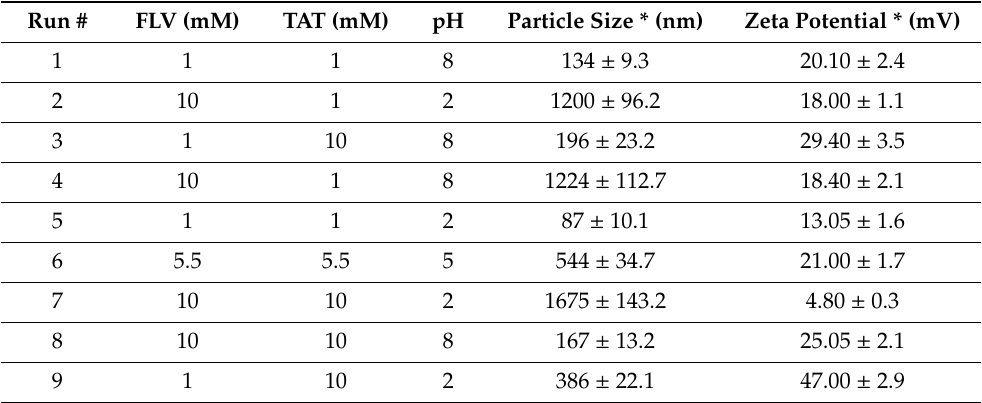
Table 1. Formulation variables fluvastatin concentration (XI), transcription peptide concentration (X2), and pH of the medium (X3) of FLV–TAT formulations and their observed responses (particle size (Y1) and zeta potential (Y2)), as suggested by the factorial design.